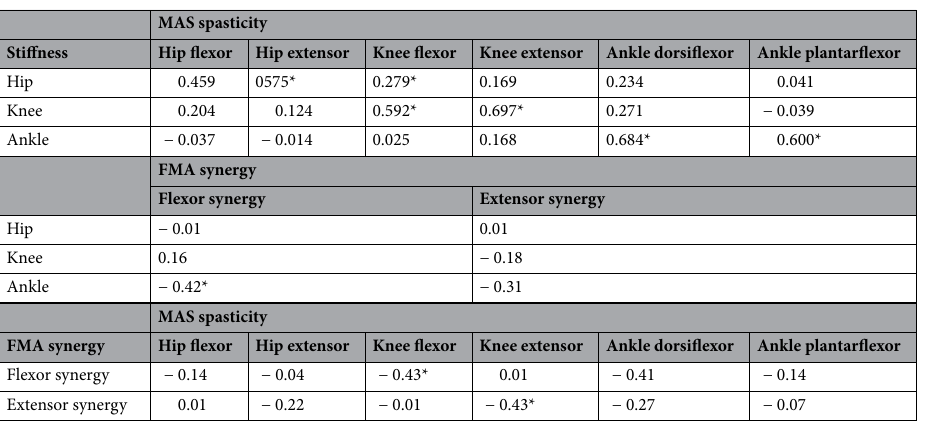
Table 5. Spearman’s rank correlation between MAS, stiffness, and FMA synergy. MAS modified Ashworth scale, FMA Fugl-Meyer assessment; *Aenotes within-group significance at P < 0.05.